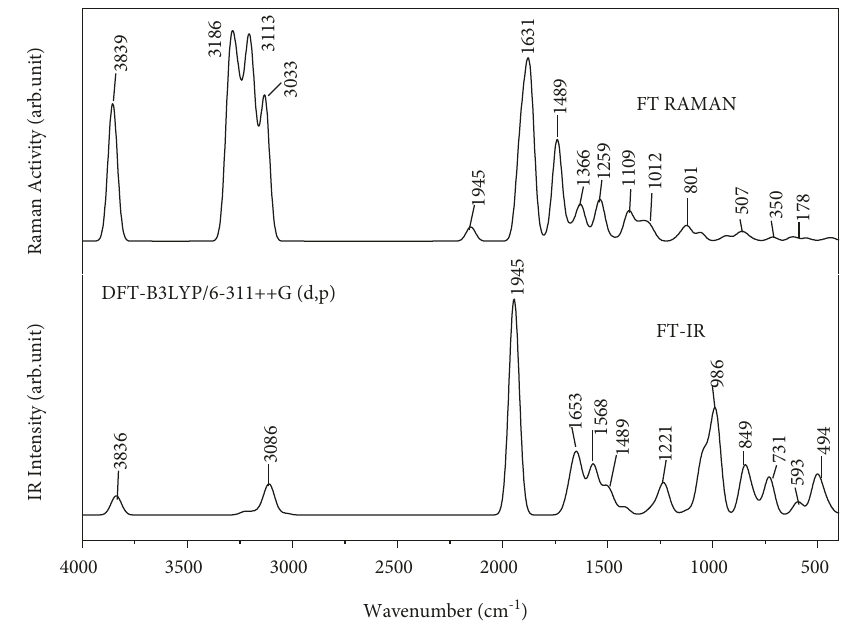
Figure 2: Theoretical FT-IR and FT Raman spectrum of 3M2VPP. Table 2: Wave numbers (cm − 1 ) and relative intensities of observed and calculated Fourier infrared and Raman spectra of 3M2VPP. Unscaled frequency (cm − 1